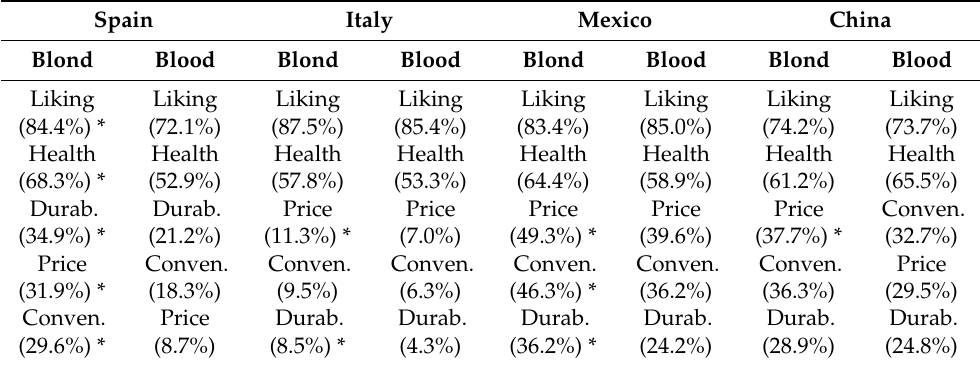
Table 3. Percentage of participants from each country (of those who stated consuming each orange type habitually) who selected each reason to consume. Conven.-Convenience. Durab.-Durability.